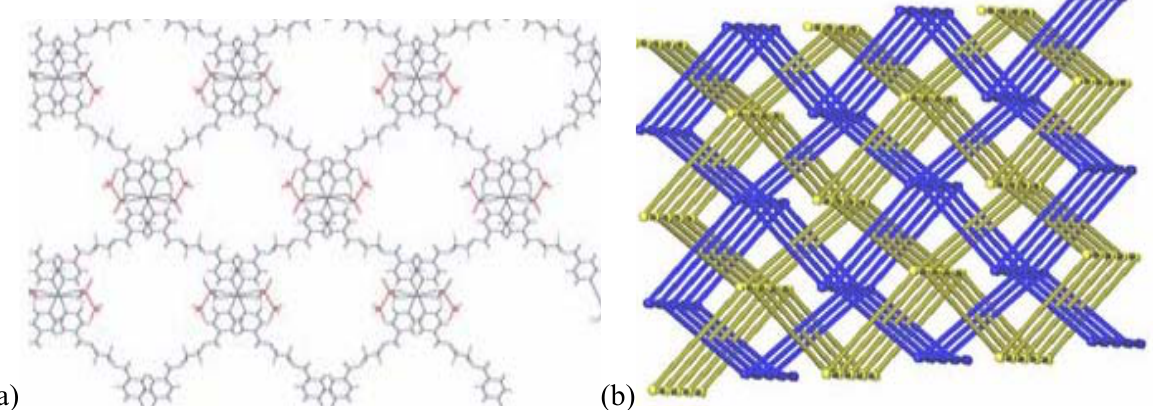
Figure 7. (a) 3D-net of 7 showing large cavities; (b) interpenetrating nets in compound 7